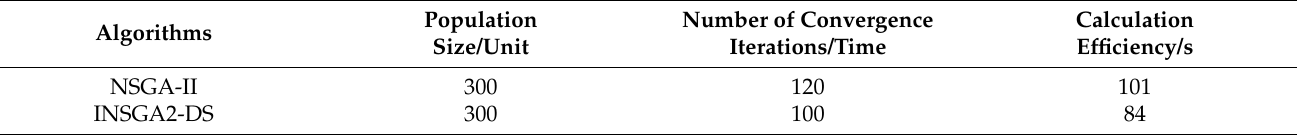
Table 4. Comparison of NSGA-II and INSGA2-DS